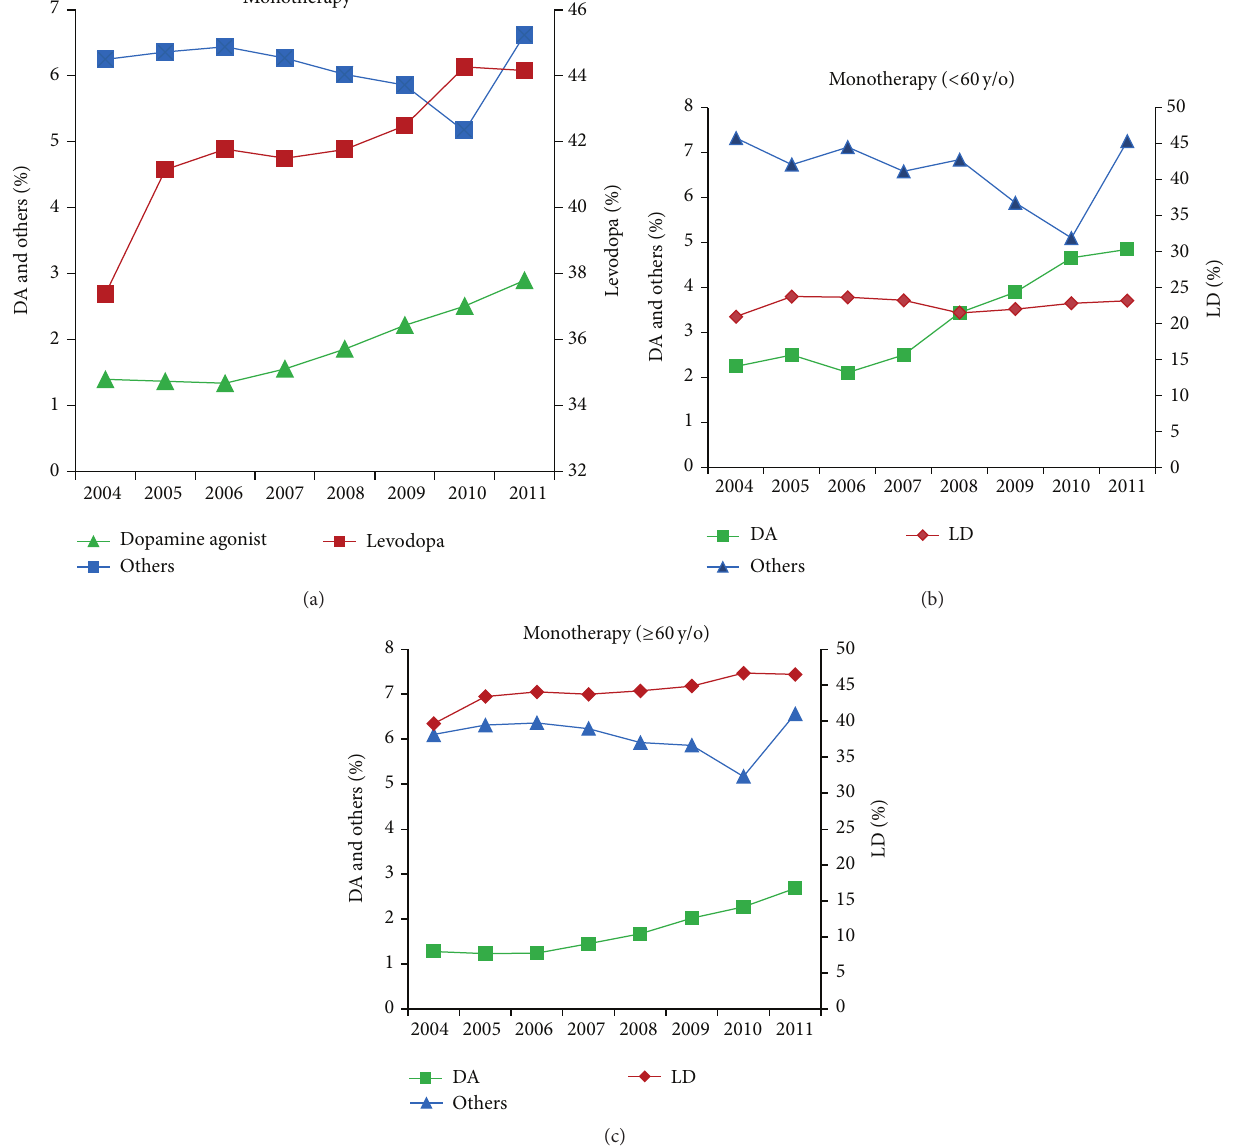
Figure 1: Time trends for antiparkinsonism monotherapy prescription patterns from 2004 to 2011 for the total population (a) stratified by age < 60 years (b) or ≥ 60 years (c). LD: levodopa; DA: dopamine